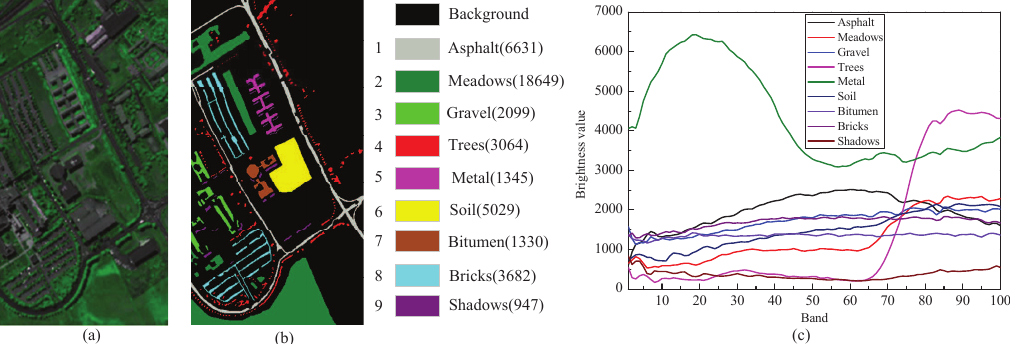
Figure 5. PaviaU hyperspectral image: ( a ) HSI in false color; ( b ) ground truth; and ( c ) spectral curve. (Note that the number of samples for each class is shown in